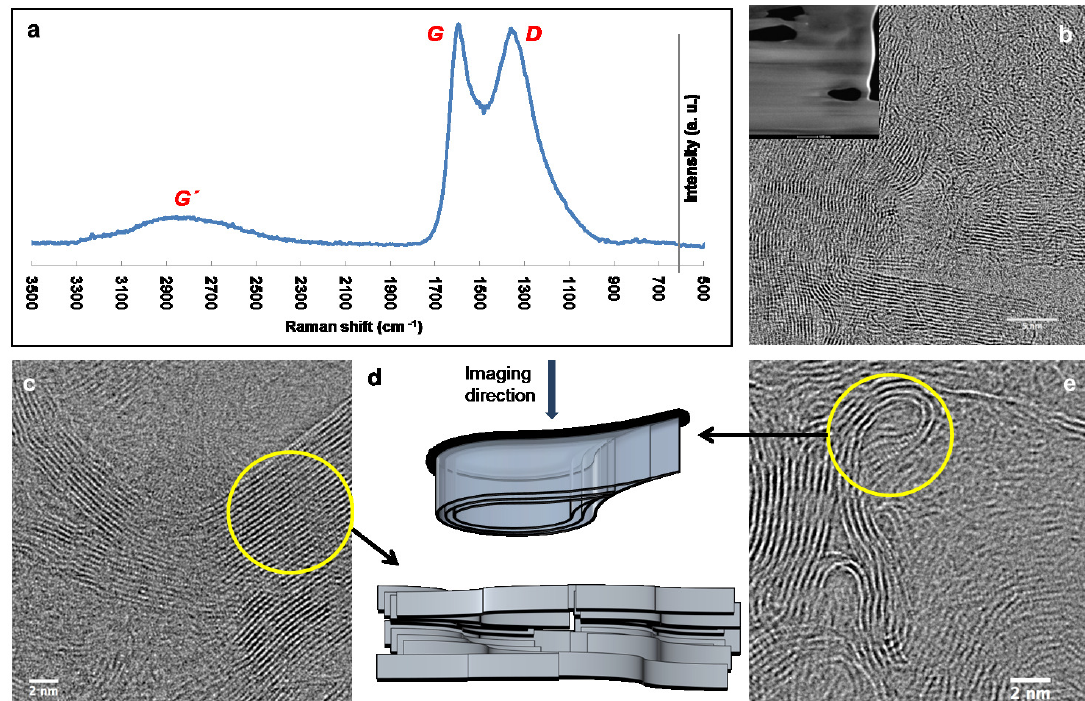
Figure 4. Microstructural characterization of IP-Dip-derived glassy carbon. ( a ) Raman spectrum; ( b ) Transmission Electron Microscopy (TEM) image showing the microstructure observed in the majority of the material (inset: Focused Ion Beam (FIB) milled sample used for TEM analysis); ( c ) TEM image featuring a graphitizing region; ( d ) Pictorial representation of possible 3D arrangement of graphene sheets in the material (locations highlighted by circles); ( e ) TEM image featuring strongly folded graphene sheets. Scale bars: ( b ) 5nm; ( c , e )